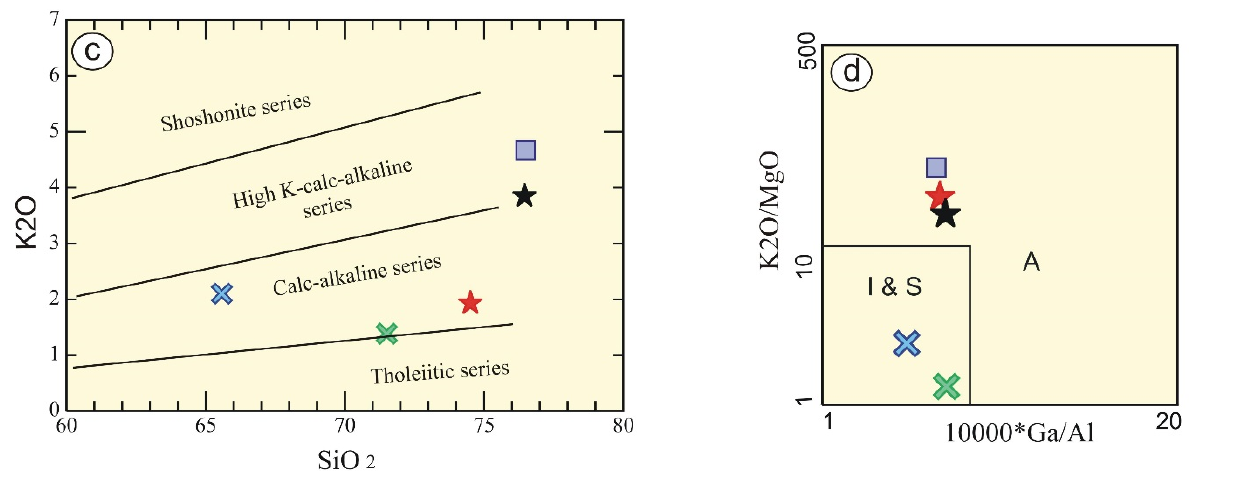
Figure 3. Classification and magma-type diagrams of Homrit Waggat rocks using: ( a ) SiO 2 vs. Na 2 O + K 2 O diagram [18]; ( b ) Ab-Or-An normative diagram [19]; ( c ) SiO 2 vs. K 2 O diagram [20]; and ( d ) 10,000*Ga/Al vs. K 2 O/MgO diagram [21].